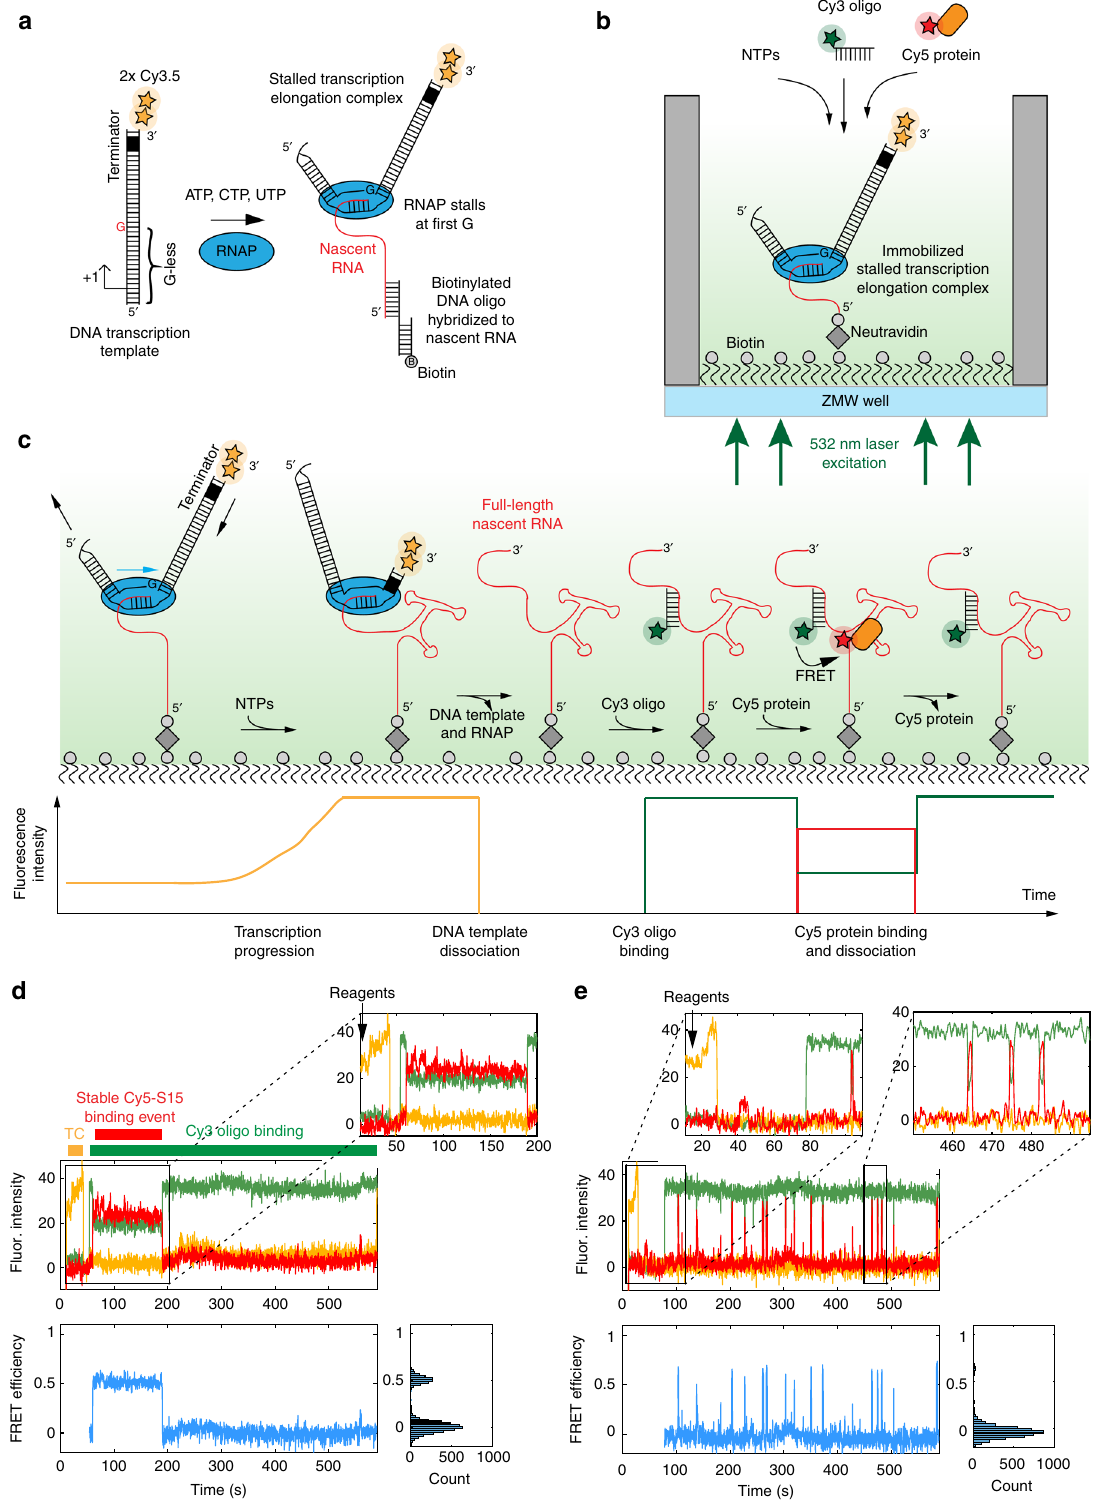
Fig. 1 Experimental approach for monitoring transcription of and protein binding to single RNA molecules. a Stalled transcription elongation complex formation. b , c Experimental setup to observe transcription and protein binding to the same nascent RNA molecule in real time. d , e Representative single- molecule traces with fl uorescence intensity (top), FRET ef fi ciency (bottom) and its probability distribution (bottom right) for a single transcribing RNA molecule binding to 5 nM r-protein S15, representing a natively folded (N-class) ( d ) or partially folded (P-class) nascent RNA molecule ( e ). Transcription elongation (TC, orange), Cy5-S15 binding (red) and Cy3-oligo binding (green) are indicated as bars in ( d ). NTPs, Cy3-oligo and Cy5-S15 protein (reagents) were delivered simultaneously at 14.4 s ( b ), which is indicated by an arrow in ( d , e ). A single laser at 532 nm was used to directly excite both the Cy3 and Cy3.5